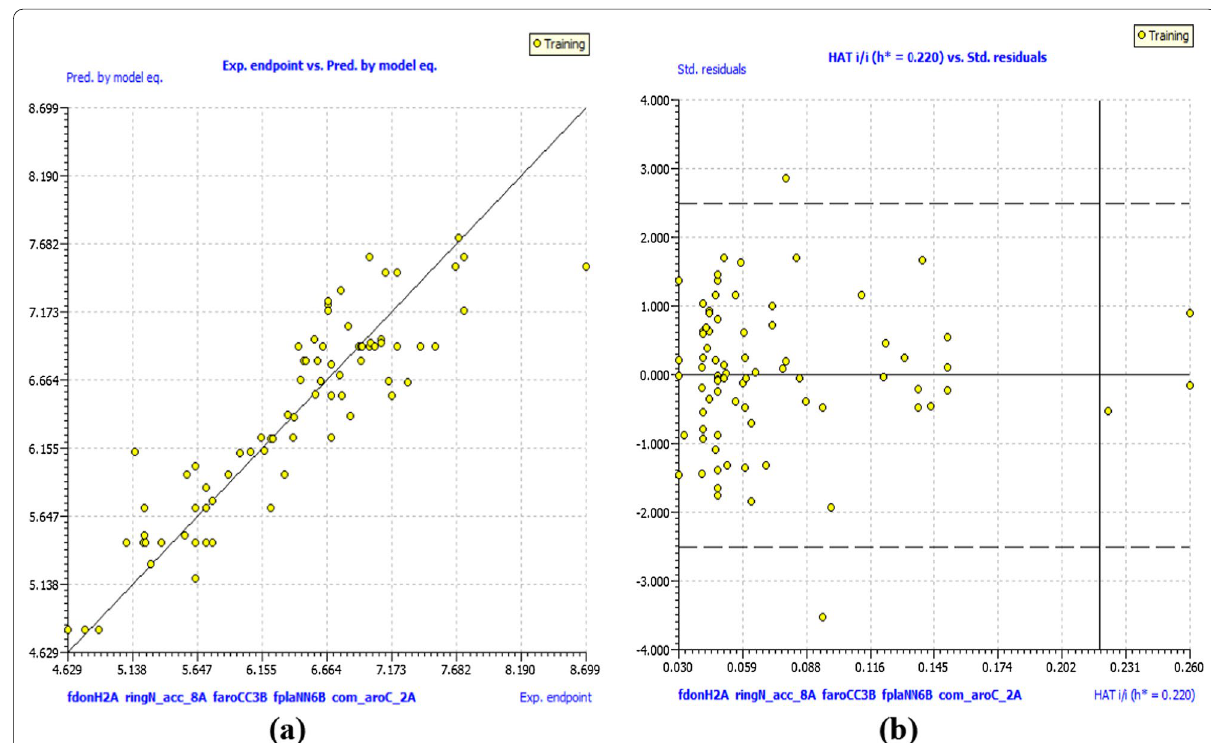
Fig. 4 Different graphs associated with the developed QSAR model (full set model). a Experimental versus predicted P EC 50, b Williams plot to assess applicability domain of